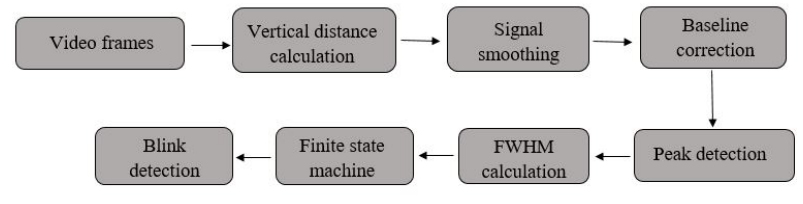
Figure 1. Overview of the proposed technique.